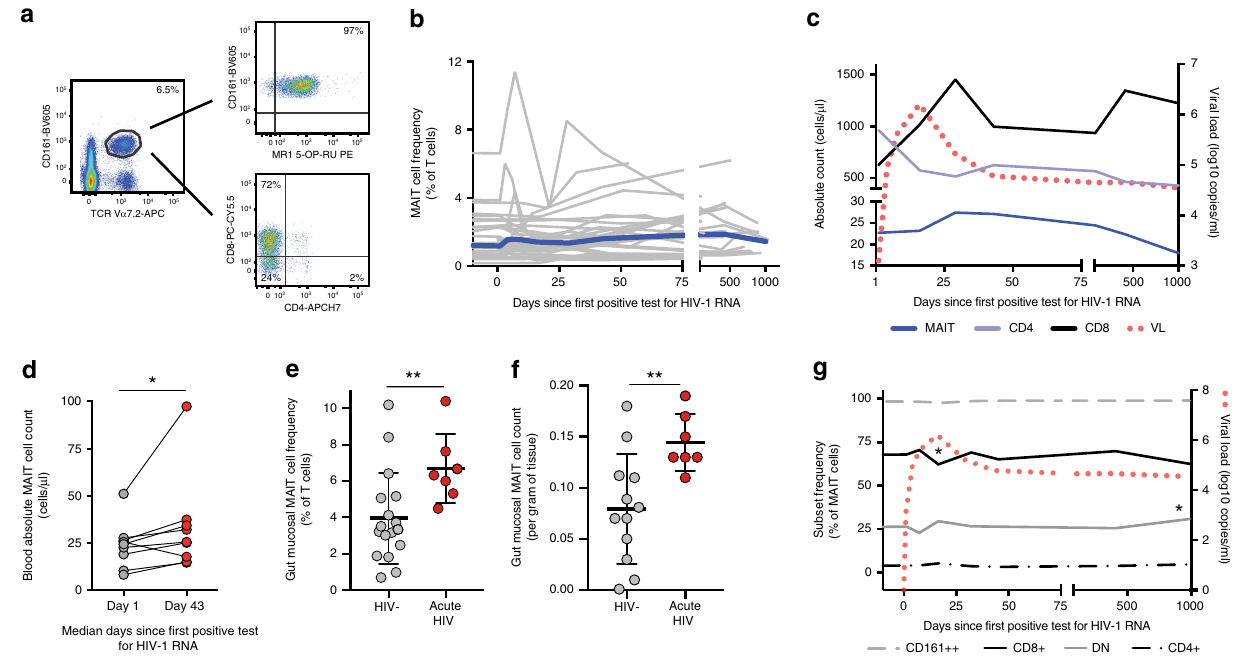
Fig. 1 MAIT cell activation and dynamics in the RV217 acute HIV-1 infection cohort. a Representative fl ow cytometry plots of a pre-infection time point from one individual enrolled in the RV217 acute capture cohort showing identi fi cation of MAIT cells as CD161 ++ V α 7.2 + of CD3 + CD14-CD19- live lymphocytes in PBMC. Con fi rmation of MAIT cell identi fi cation using the 5-OP-RU loaded MR1 tetramer, and the relative distribution of CD8 and CD4 positivity within the MAIT cell gate is displayed. b MAIT cell frequency as a percentage of CD3 + T cells is shown longitudinally in individuals with acute HIV-1 infection (gray), with median frequency (blue) ( n = 29). c Median absolute counts (cells/ μ l of blood) of MAIT cells relative to conventional CD4 and CD8 T cells and HIV-1 viral load displayed over time in acute HIV-1 infection ( n = 29). d MAIT cell absolute counts in 9 donors where matching data points were available from days 1 and 43 after HIV-1 infection. e MAIT cell percentages out of total CD3 + cells isolated from rectal biopsies from individuals with acute HIV infection ( n = 7), and matched uninfected controls ( n = 17). f MAIT cell count per gram of rectal biopsy tissue from individuals with acute HIV CD8, CD4, and double negative expression in MR1 tetramer-de fi ned MAIT cells displayed ( n = 19). * p ≤ 0.05, ** p ≤ 0.01, *** p ≤ 0.001. In d ,